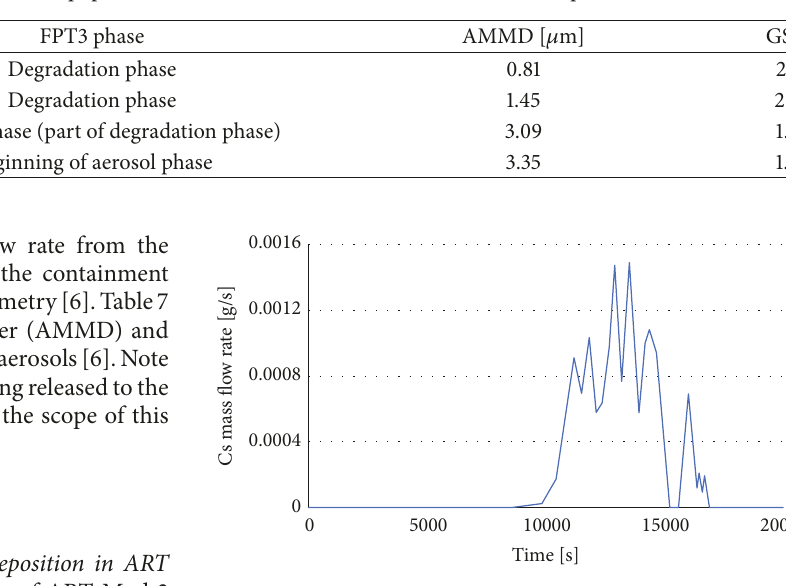
Figure 2: Cs mass flow rate to containment vessel in Ph´ebus FPT3 experiment measured with online gamma spectrometry